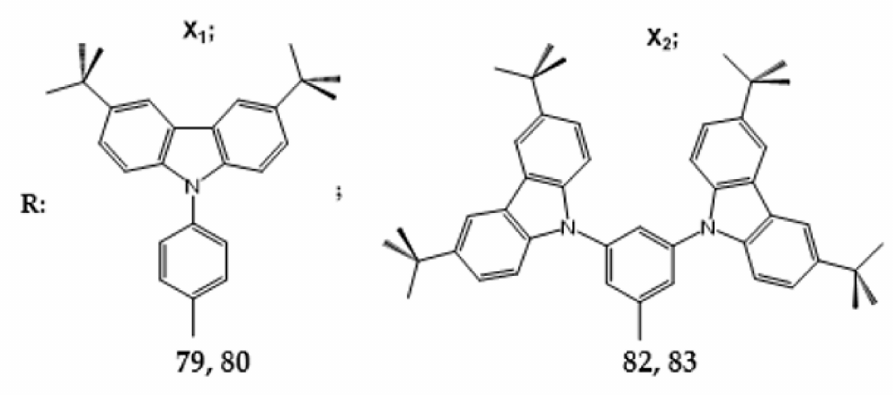
Scheme 25. Synthesis of zinc porphyrinates with first-generation ( 79 ) and